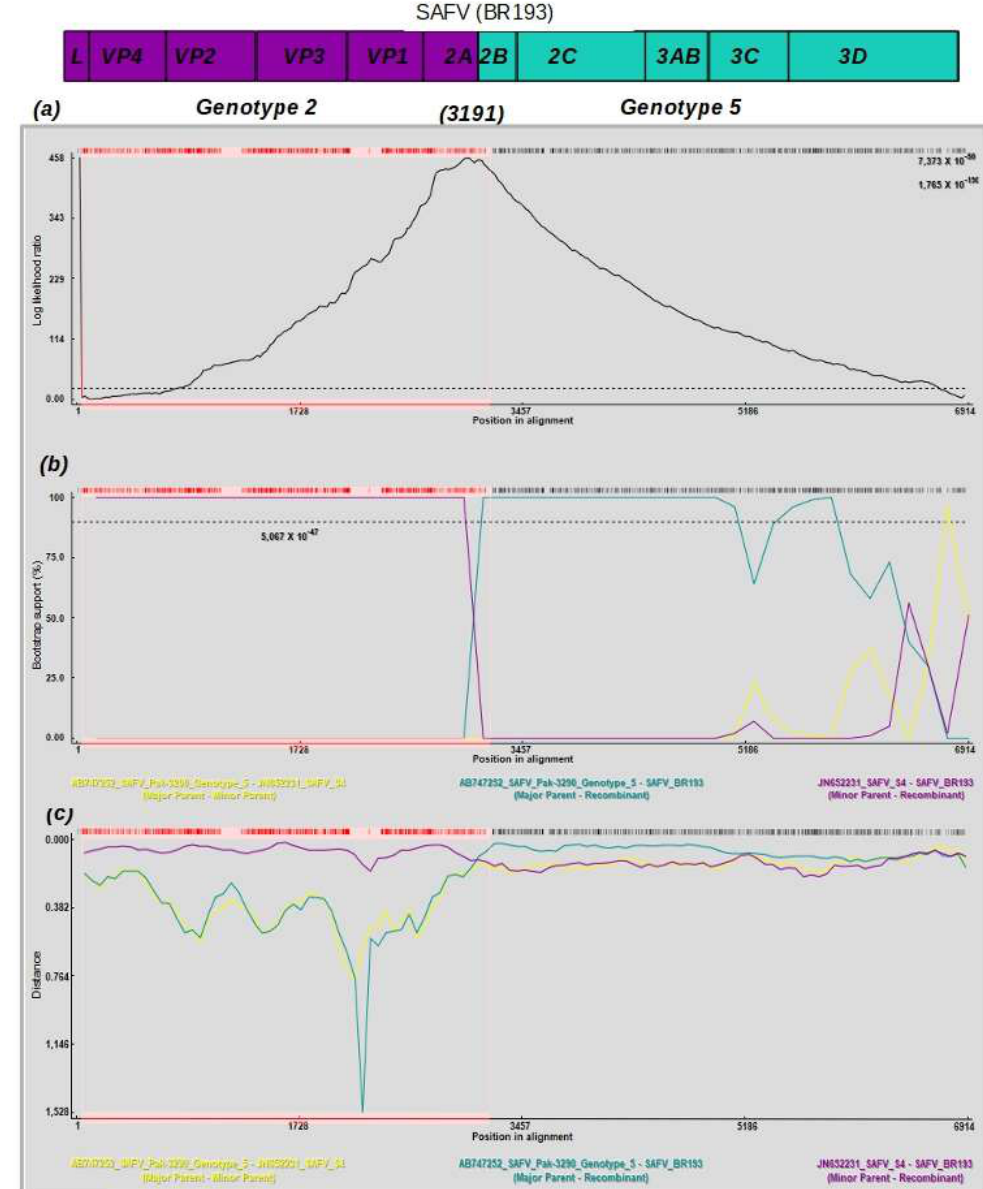
Figure 4. Recombination pattern of SAFV BR193. The upper panel shows the position of the recombination breakpoint in the polyprotein of SAFV ( a ). This is based on the LARD method that detects recombination breakpoints by scanning an alignment of three sequences (one recombinant and two putative parental sequences) for the point (likelihood ratio test) in the alignment that optimally separates regions of conflicting phylogenetic signal. The plot (solid black line) indicates the point of maximum likelihood and the values above the peak are the approximate p -value. There are two p -values calculated (upper right in the plot). The upper value corresponds to a breakpoint detected at position 63, this peak was not confirmed by other methods. The second value in the upper right of the plot correspond to the breakpoint at the position 3191 of the polyprotein. The upper dashed black and red lines indicate partitions in the alignment that presented conflicting trees. Dashed lines indicate the cutoff value based on Bonferroni correction test. The vertical dashed arrow indicates the breakpoint position in the SAFV polyprotein. The bootscanning method was used to determine the parental genotypes that compose the recombinant strain BR193 ( b ). Colored lines represent the